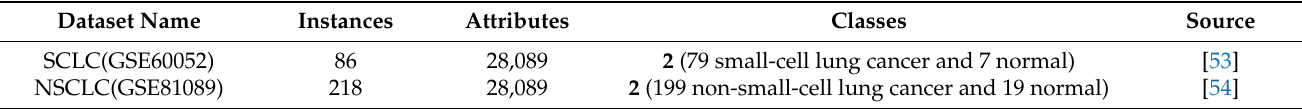
Table 1. Summary of the datasets used in this